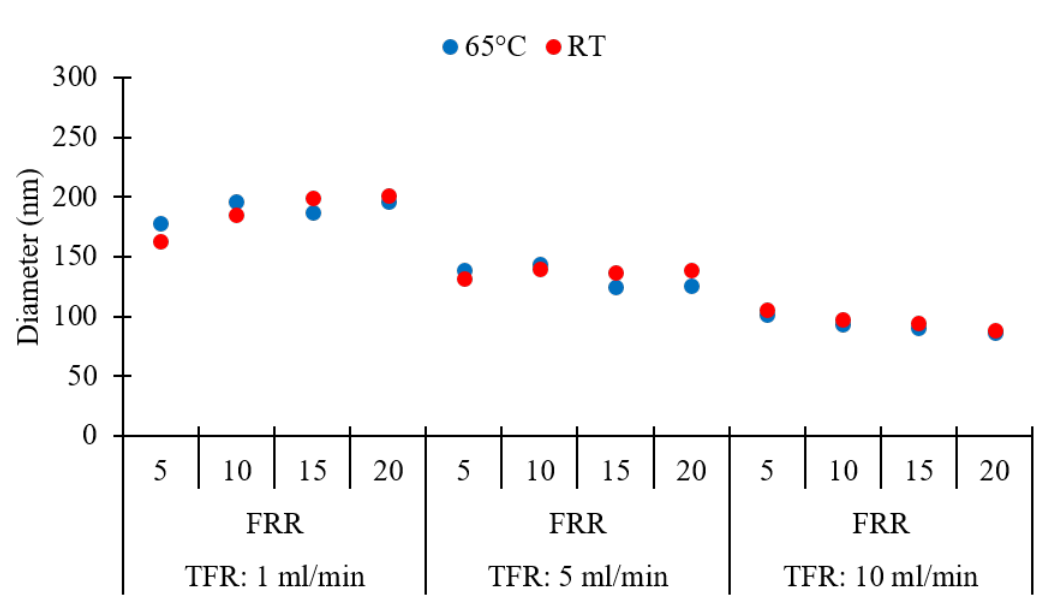
Figure 12. E ff ects of temperature on the Z-average size of di ff erent liposome batches, obtained at Figure 12 di ff erent values of total flow rate (TFR) and flow rate ratio (FRR). RT: room temperature. Data represent the means of three measurements with corresponding standard deviations. Refer to Table 1 (batch codes #27 DPPC to #38 DPPC, and #46 DPPC to #57 DPPC) for the corresponding experimental conditions, lipid compositions, and numerical data of mean values and standard